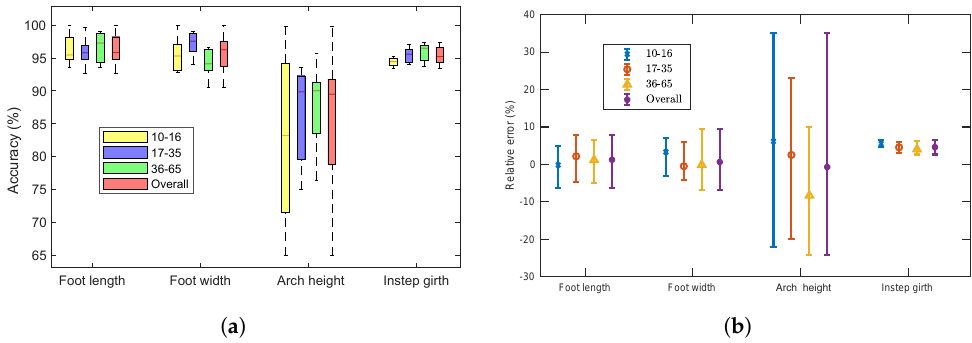
Figure 9. Accuracy and relative error for different age groups: ( a ) accuracy of four foot measurements; ( b ) mean and its standard error (error bar) of relative difference (%) between MM and